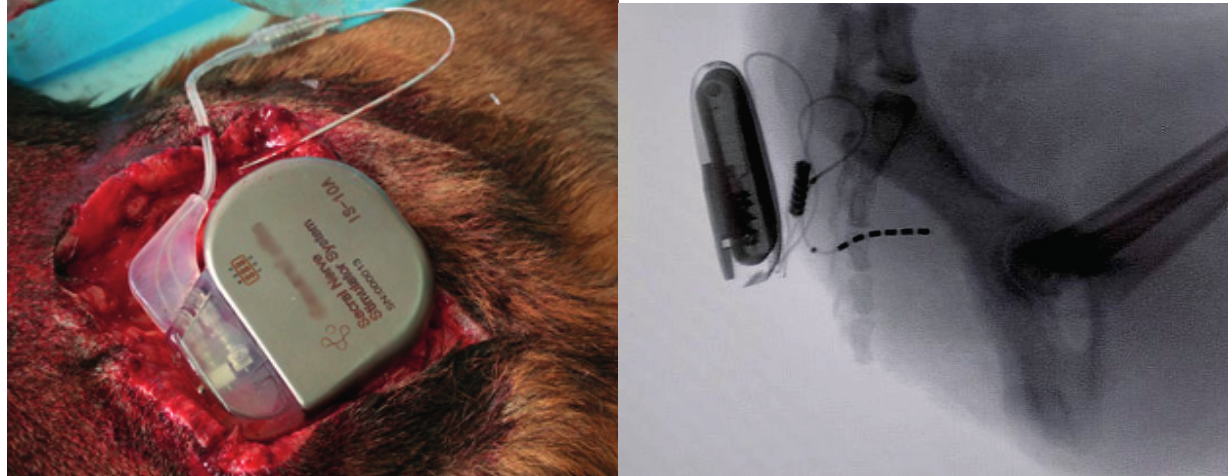
Figure 8. Animal model (dog) for Chinese Sacral Neuromodulation Implant System (SacralStim) in